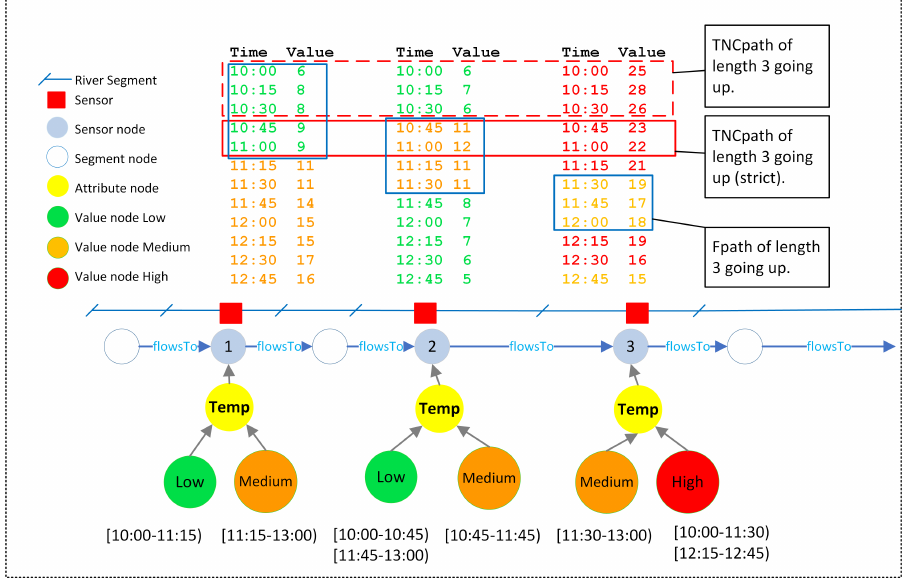
Figure 9. River Network Continuous Path of Temperature going